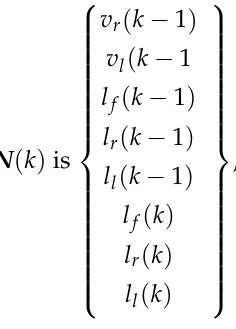
where v r is the speed of right wheels, v l is the speed of left wheels, l f is the distance to an obstacle in front of the model, l r is the distance to the wall on the right side, l l is the distance to the wall on the left side, k is the number of the sample.